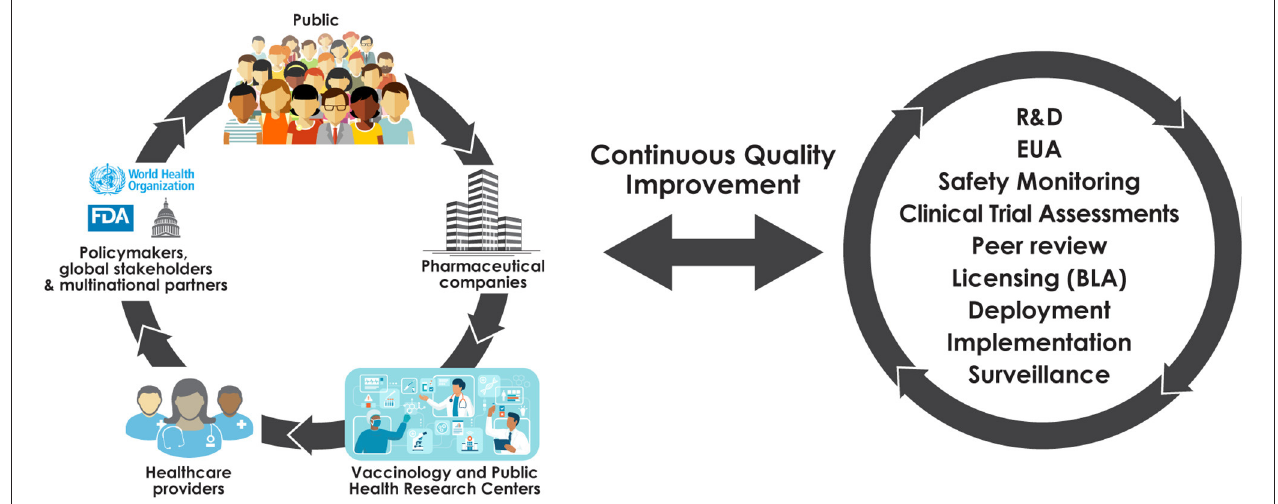
FIGURE 1 | A learning immunization